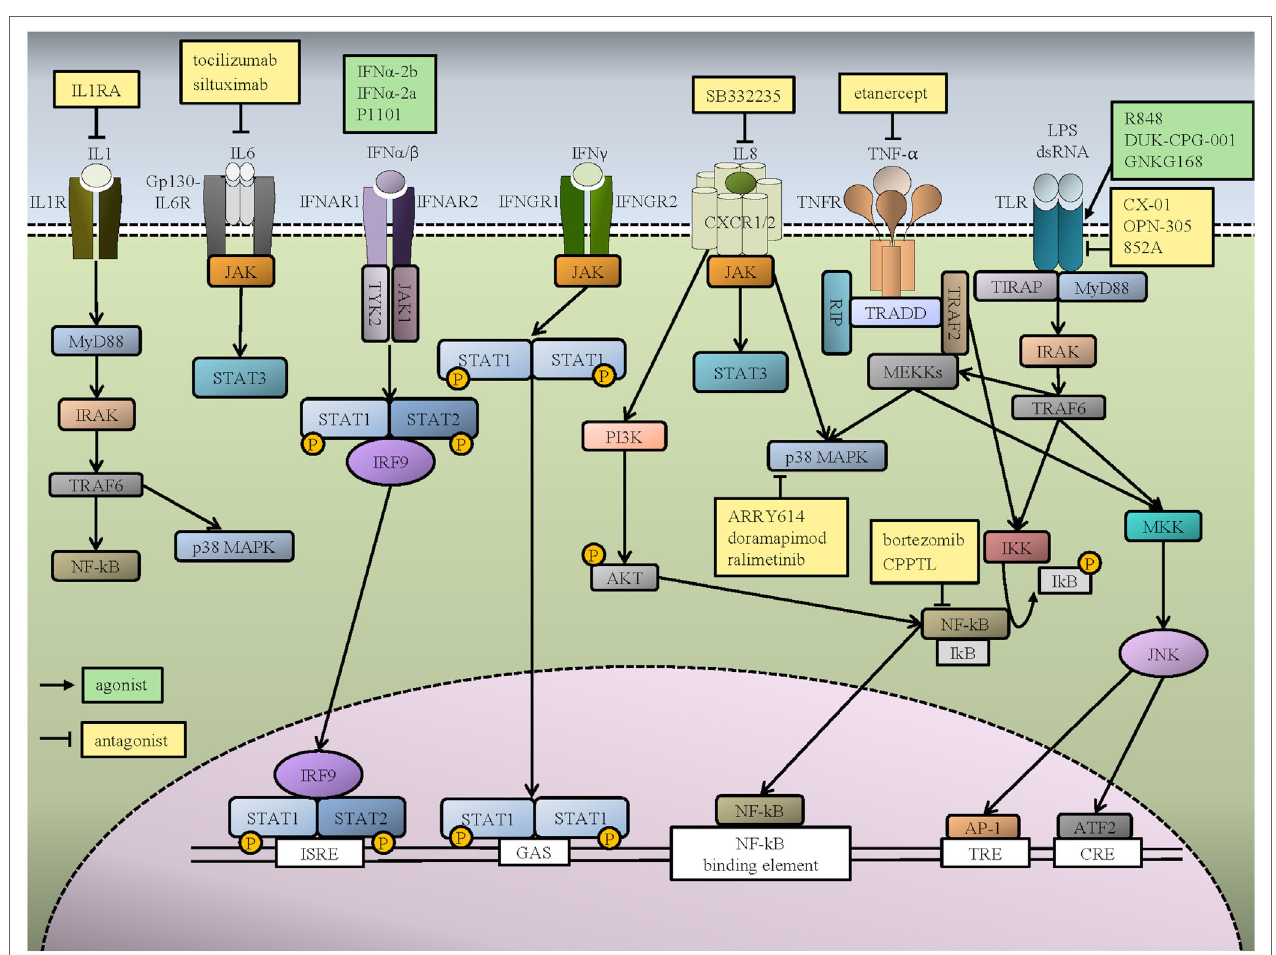
FiGURe 1 | Inflammatory signaling pathways in hematopoietic cells and potential therapeutic targets for myeloid malignancies. Interleukin (IL)-1 β activates the IL-1 receptor (IL-1R), which causes dimerization and intracellular downstream signaling via MYD88 and IRAK. This activates multiple downstream pathways, including NF- κ B and p38 MAPK. Two interleukin 6 (IL-6) molecules form a hexamer with two IL-6 receptors (IL-6R) and two GP-130 molecules, which signal via the JAK1–STAT3 pathway. The binding of IFN- α / β to IFNAR receptors activates TYK2 and JAK1, which phosphorylate STAT1 and STAT2. The association of IRF9 and phosphorylated STAT1 and STAT2 activates transcription by binding to IFN-stimulated response elements (ISREs). IFN- γ binding to IFNGR receptors promotes STAT1 phosphorylation by JAK. The STAT1 homodimer translocates to the nucleus and activates IFN- γ -activated site (GAS) sequences. IL-8 binds to its receptor, either CXCR1 or CXCR2, which can activate various downstream signaling pathways, including PI3K/AKT, JAK/STAT, and MAPK. There is extensive crosstalk between tumor necrosis factor alpha (TNF- α ) and Toll-like receptor (TLR) signaling pathways. TNF- α binds to its receptor TNFR and activates IKK via RIP and TRAF2 recruitment by TRADD. IKK activation promotes IKB phosphorylation and release of NF- κ B, which can then translocate to the nucleus. TNF- α binding also activates p38 and MEKK. The activation of MEKK causes JNK to stimulate AP-1, which binds to TPA DNA-response elements (TRE) and ATF2, which binds to cAMP- responsive elements (CRE). Activation of TLR by infectious molecules initiates the signaling pathway through MyD88, which recruits IRAK to bind TRAF6 and activate NF- κ B and JNK pathways. Representative pathways agonists (green boxes) and antagonists (yellow boxes) that are either in preclinical or clinical investigation are